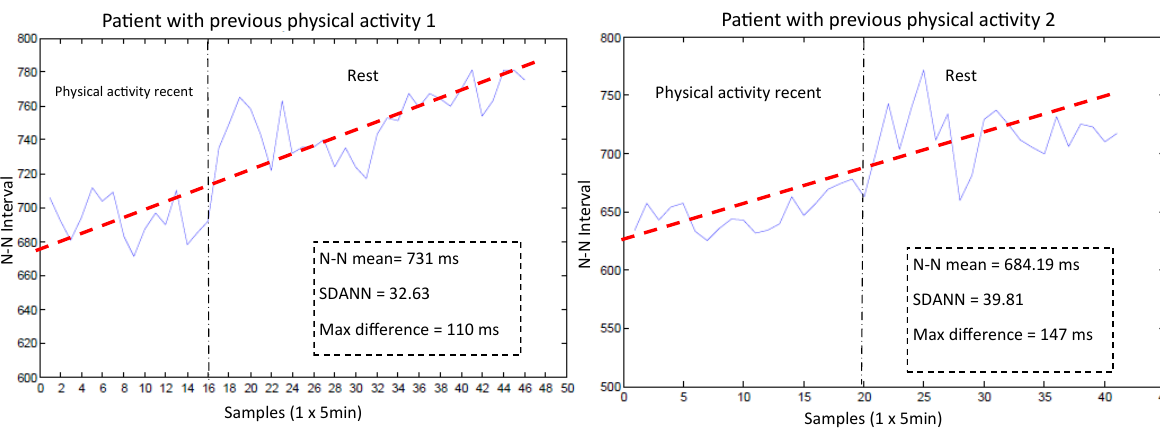
Figure 14. Tests of HR measurements in patients following physical